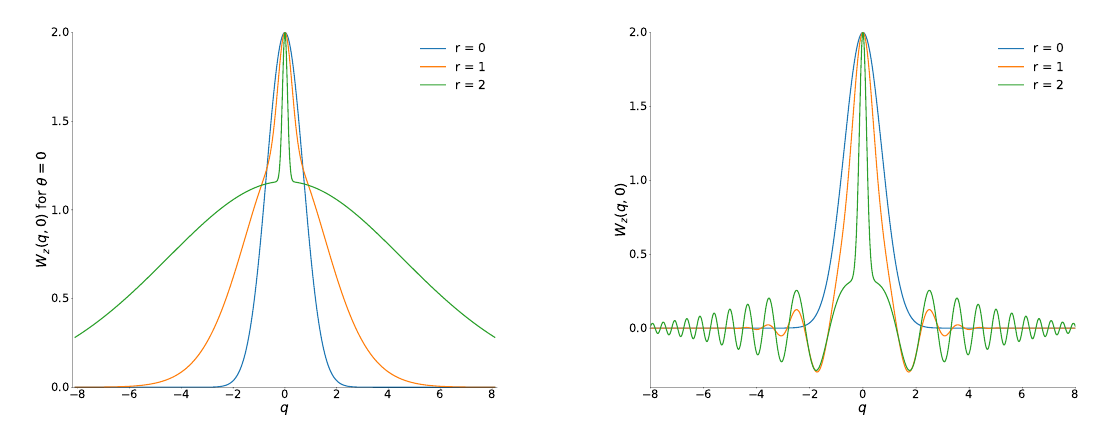
Figure 2. The section W z ( q ,0 ) of EVSS for different values of the squeezing parameter r and phase θ . Left : θ = 0; r = 0,1.0,2.0. Right : θ = π /2, the same values of r . Plots of measures Equations (23) and (25) as functions of parameter c are given in Figure 3. They are compared with the plots of the normalized kurtosis K (Equation (2)). Three coefficients δ [ ρ z ]( c ) grow monotonously from 0 at c = 1 to their asymptotic values as c → ∞ , and nothing exceptional is noticed for c = c ∗ . The coefficient g ( c ) grows initially, attains a wide maximum g max ≈ 1.27 at r max ≈ 1.33 (or c max ≈ 2.68), and √ decays monotonously to g ∞ = 2/ 3 ≈ 1.155 as c → ∞ . However, the maximum of g ( c ) apparently has no correlation with the minimum of (cid:104) ˆ x 4 (cid:105) . For r (cid:28) 1 we obtain g ≈ 1 + 9 r 4 /8 and δ T [ ρ z ] ≈ 3 r 4 /8.